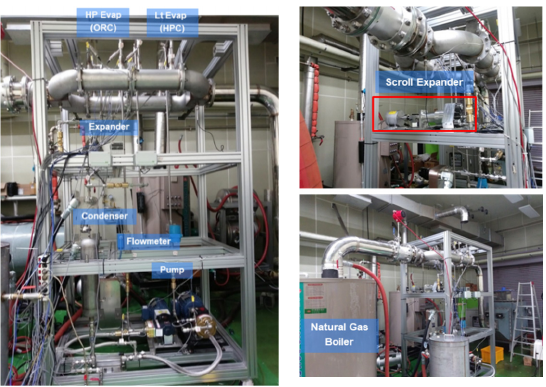
Figure 4. Photograph of the experimental setup of the WHWR system.